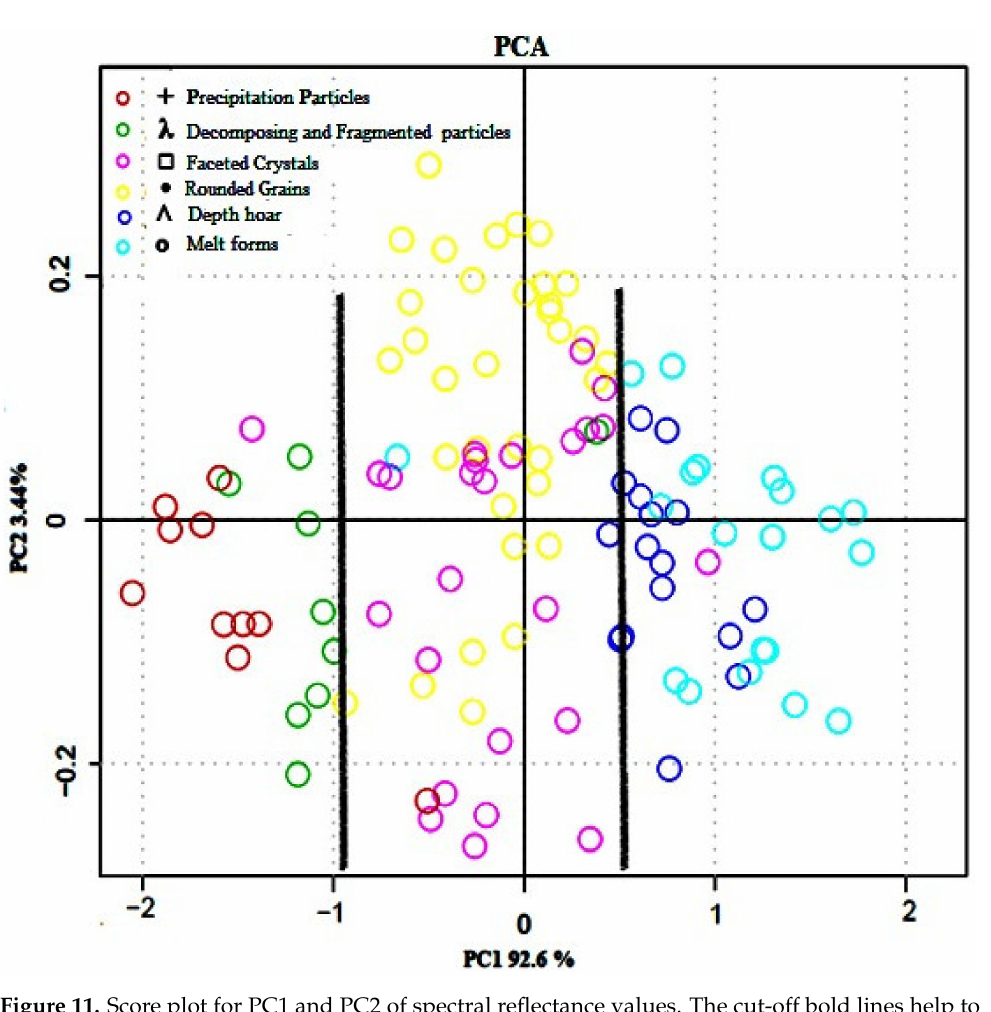
Figure 11. Score plot for PC1 and PC2 of spectral reflectance values. The cut-off bold lines help to visually distinguish among the snow classes in terms of metamorphosis degree (weakly, moderately, strongly metamorphosed